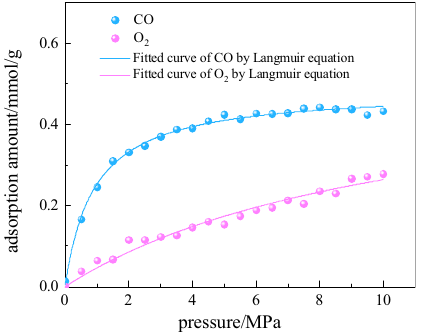
Figure 7. Competitive adsorption equilibrium isotherms of CO/O 2 mixture on coal at 308.15 K.